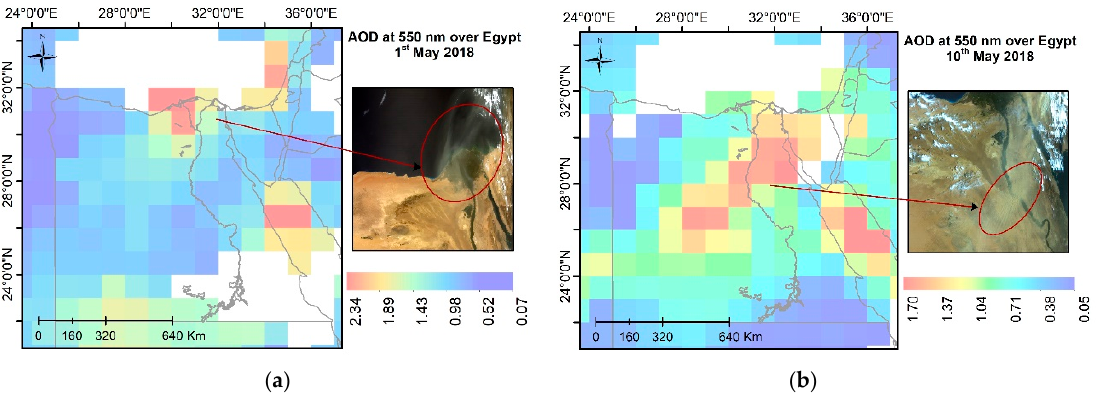
Figure 4. The observed dust storms on ( a ) 1st May 2018, and ( b ) 10th May 2018 over Egypt. * on the left, MODIS (level 3) AOD; on the right MODIS (level 1) radiance color image.